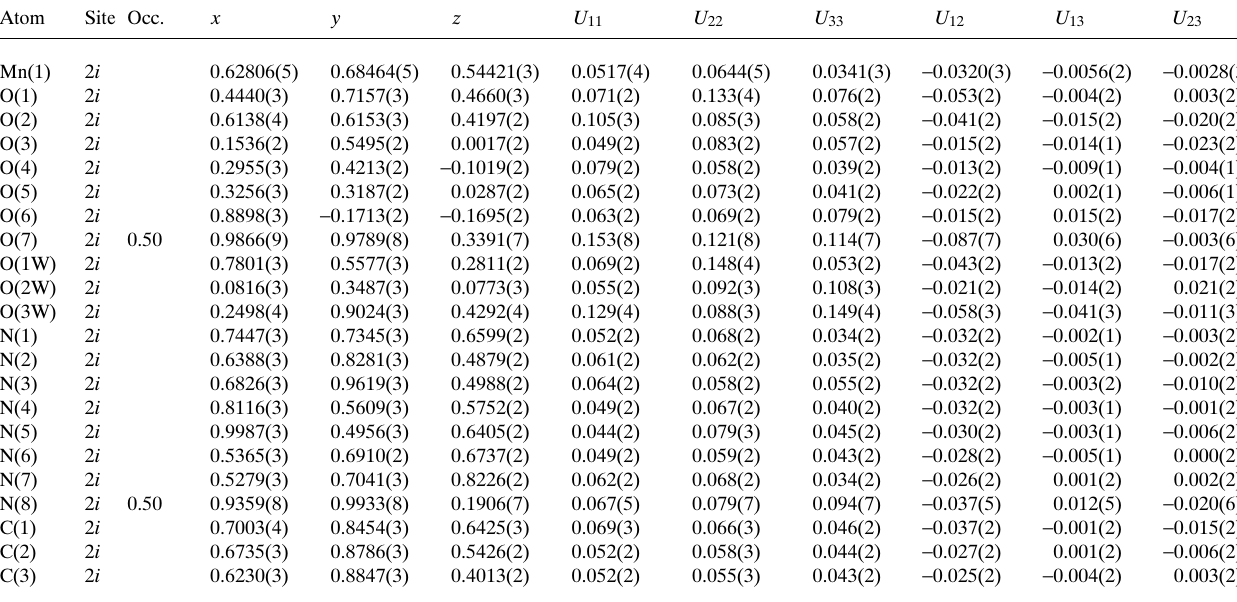
Table 3. Atomic coordinates and displacement parameters (in Å 2 ) . Atom Site Occ.